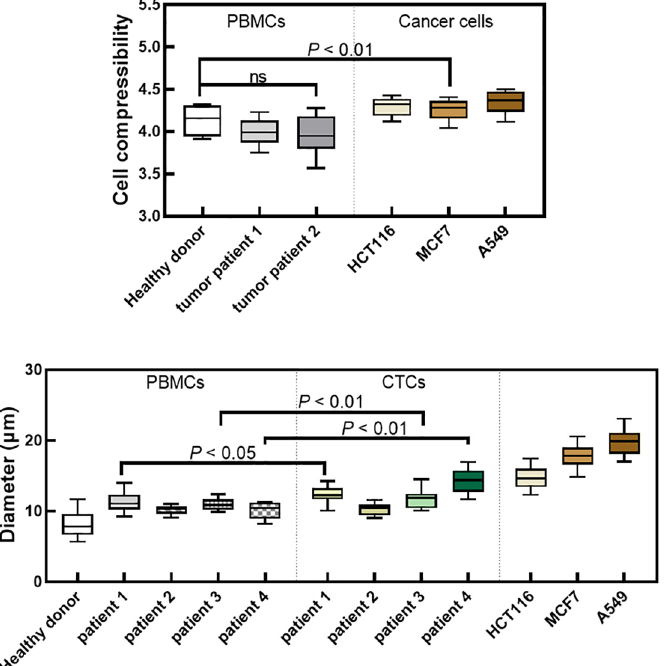
Figure 1. Cell compressibility and diameter of PBMCs from healthy donor, PBMCs from tumor patients, CTCs and cancer cell lines. The unit of cell compressibility was 10 − 10 Pa − 1 . ns indicates not statistically significant.